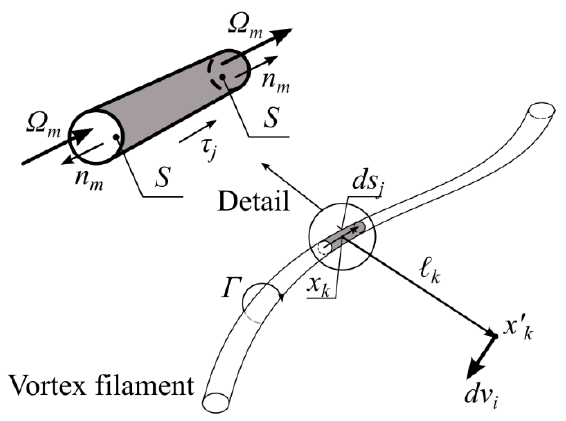
Figure 1. A vortex filament and an infinitesimal velocity induced by a vortex filament